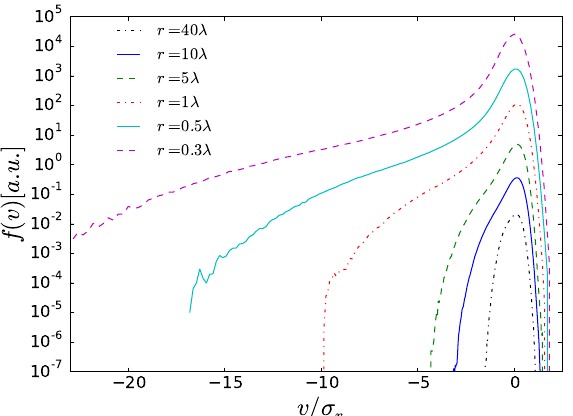
Figure 5. Evolution of the velocity increment PDF in scale (multiples of the Taylor length λ ) for the Burgers case α = 1. The PDFs are shifted vertically and normed with their corresponding standard deviation σ r for improved visualization. The pronounced left part of the PDFs is dominated by small-scale shock events, whereas the right part exhibits nearly self-similar